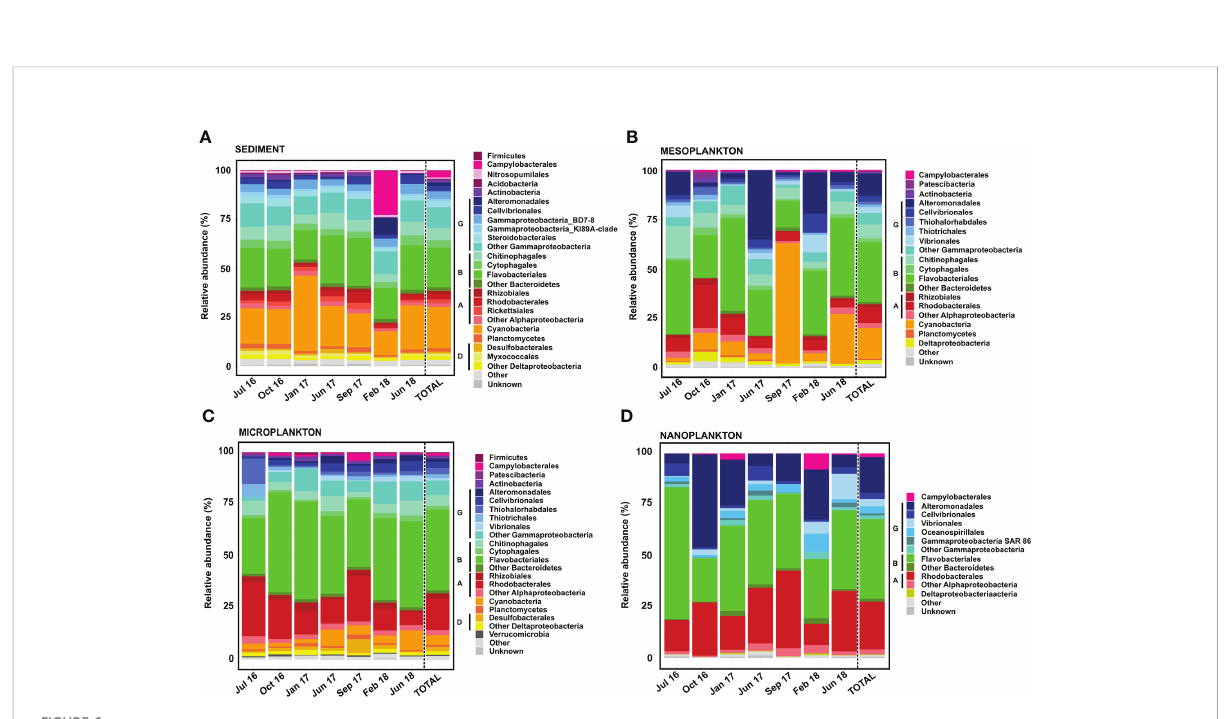
FIGURE 6 Prokaryote composition in terms of relative abundance obtained from (A) sediment, (B) mesoplankton, (C) microplankton, and (D) nanoplankton. A, Alphaproteobacteria; B, Bacteroidetes; D, Deltaproteobacteria; and G,